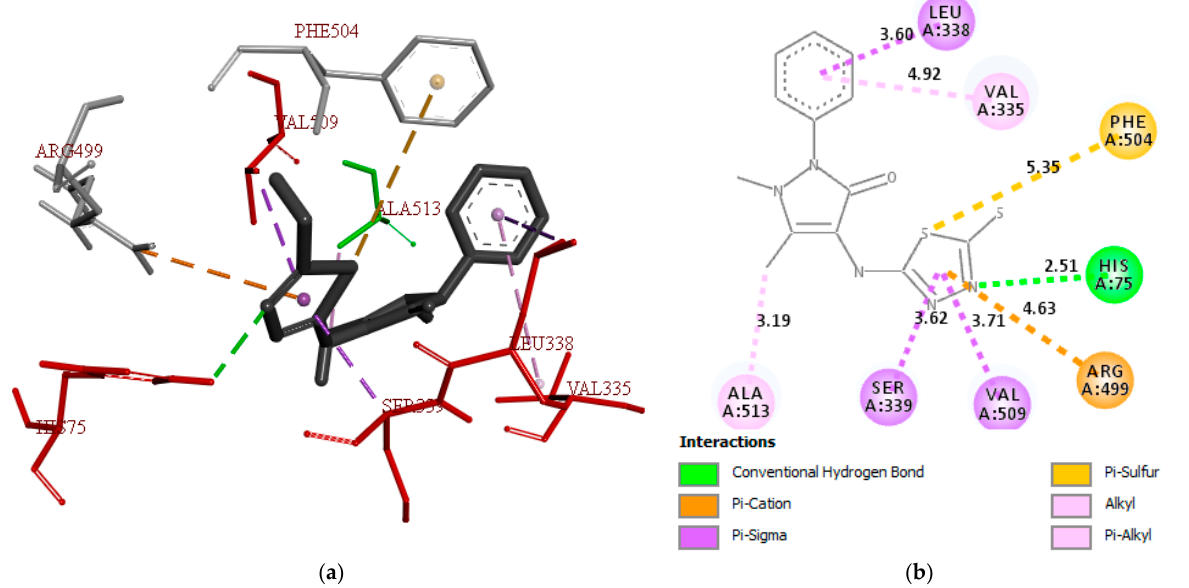
Figure 2. The binding mode of compound 2 with COX-2 enzyme (PDB 3LN1): ( a ) 3D visualization; ( b ) ligand interaction diagram of compound 2 with COX-2.